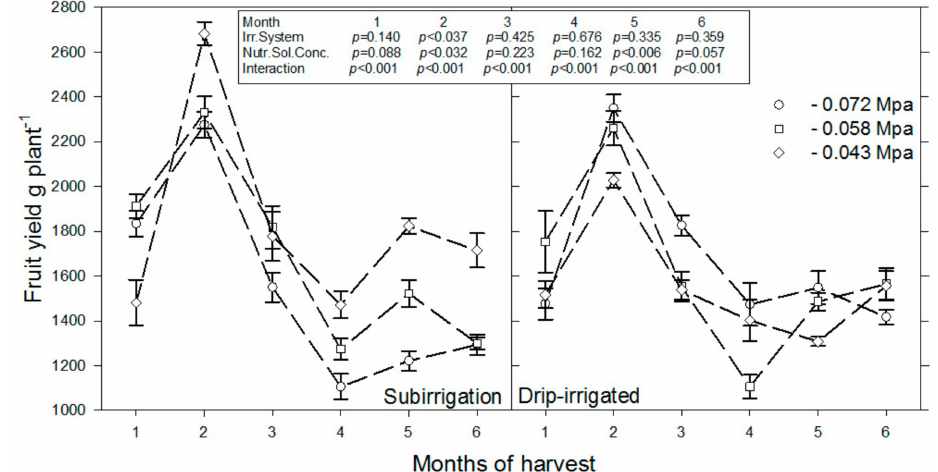
Figure 2. Fruit yield on a monthly basis in subirrigated and drip-irrigated tomato ( Solanum lycopersicum L.) plants with solutions of varying nutrient concentration. ANOVA significance for both factors, irrigation system (Irr. System) and nutrient solution concentration (Nutr. Sol. Conc.), and the interaction is shown. Means with the same lower-case letter indicate non-significant di ff erences according to Tukey´s multiple comparison test. Bars represent the standard error of the mean ( n = 4)